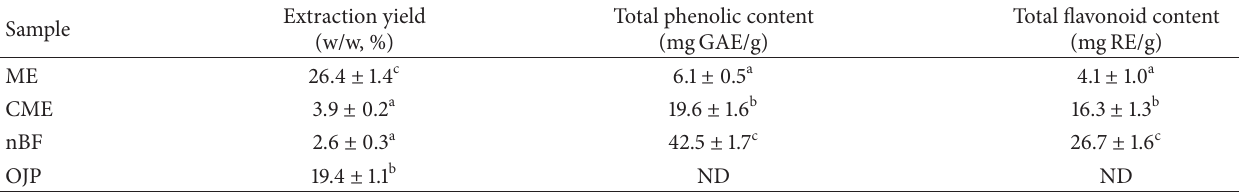
Table 5: Extraction yield, total phenolic and flavonoid contents of O. japonicus tubers extracts. Sample